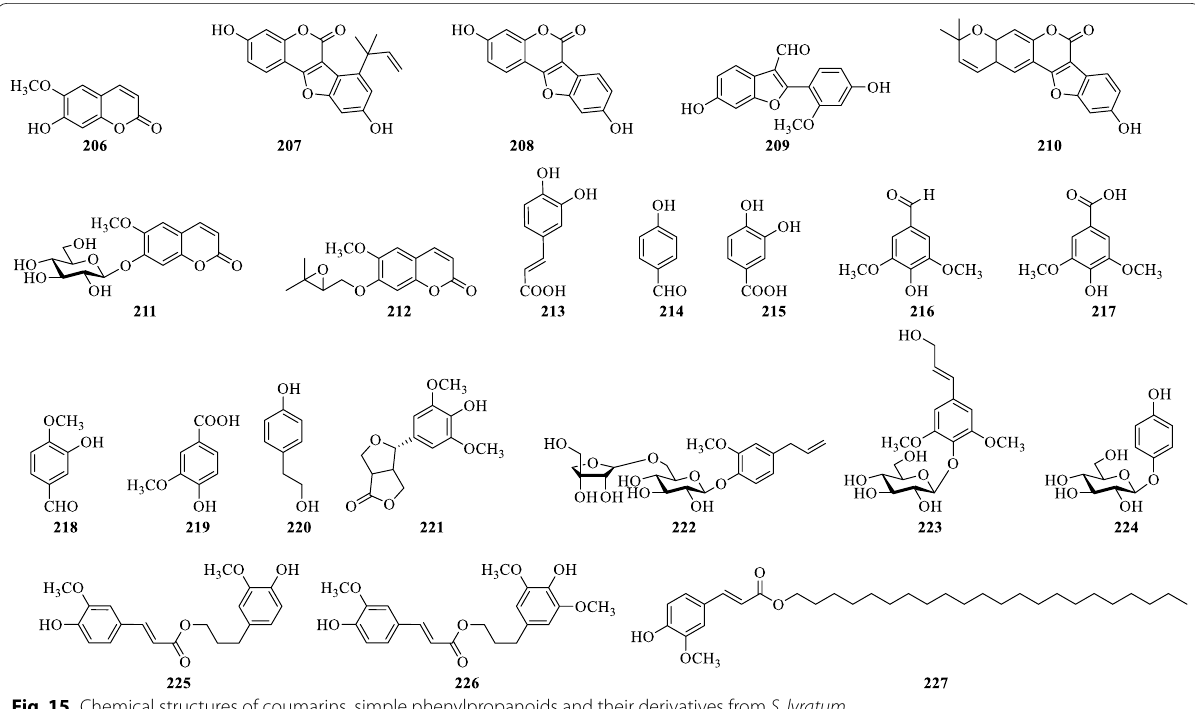
Fig. 15 Chemical structures of coumarins, simple phenylpropanoids and their derivatives from S.